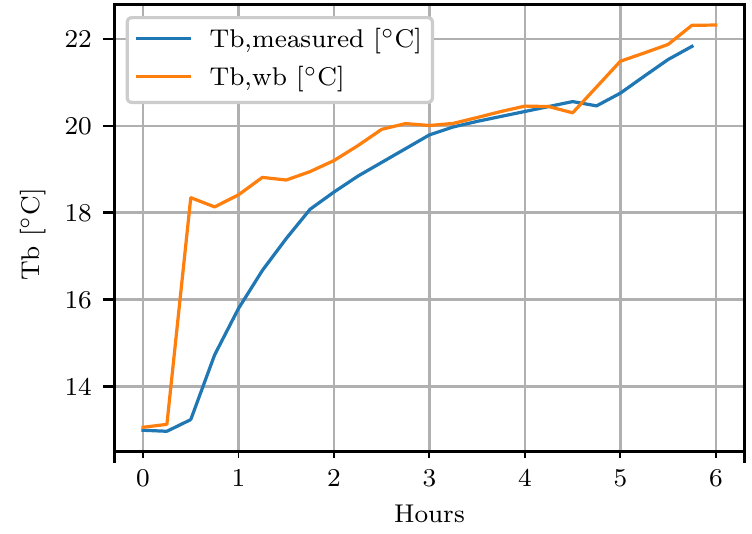
Figure 6. Water basin temperature response for a fan state